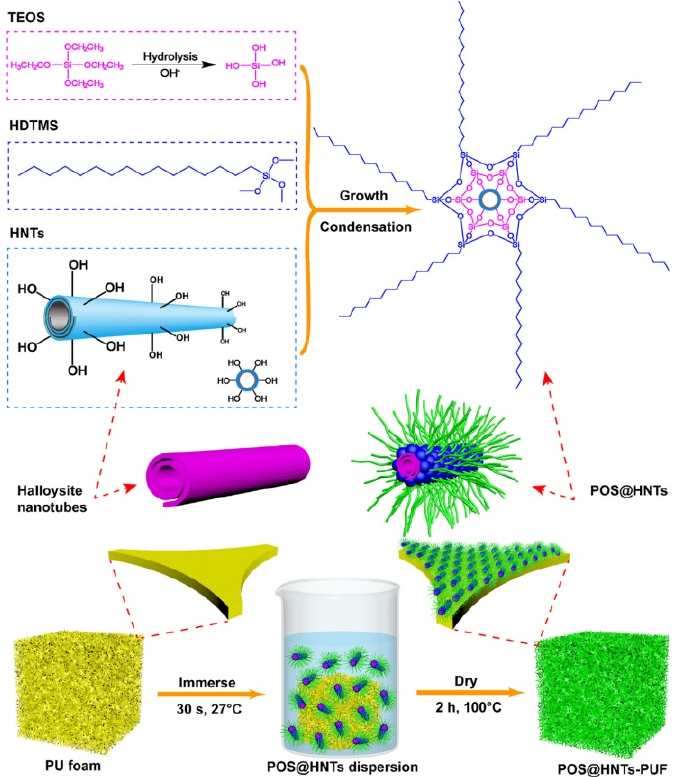
Figure 22. Preparation and reaction mechanism of the superhydrophobic POS@HNTs coated polyurethane foam. Reproduced with permission from [167].